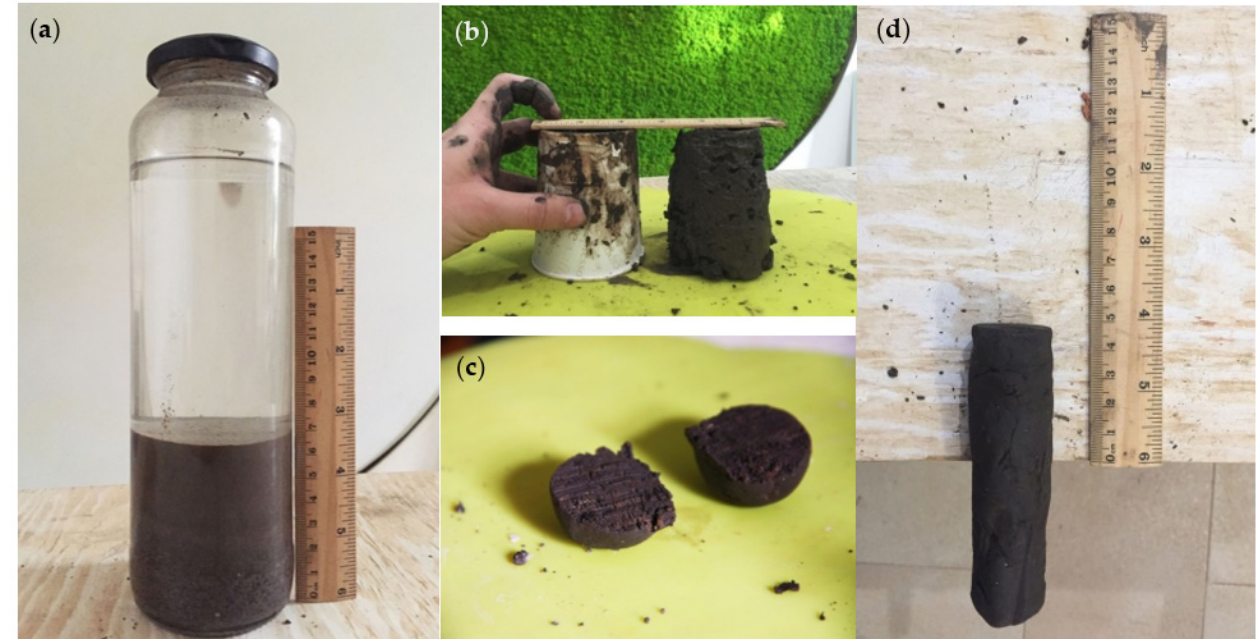
Figure 2. Preliminary cognitive tests: ( a ) simplified sedimentation test; ( b ) collapse test; ( c ) adhesion test; and ( d ) cigar test.